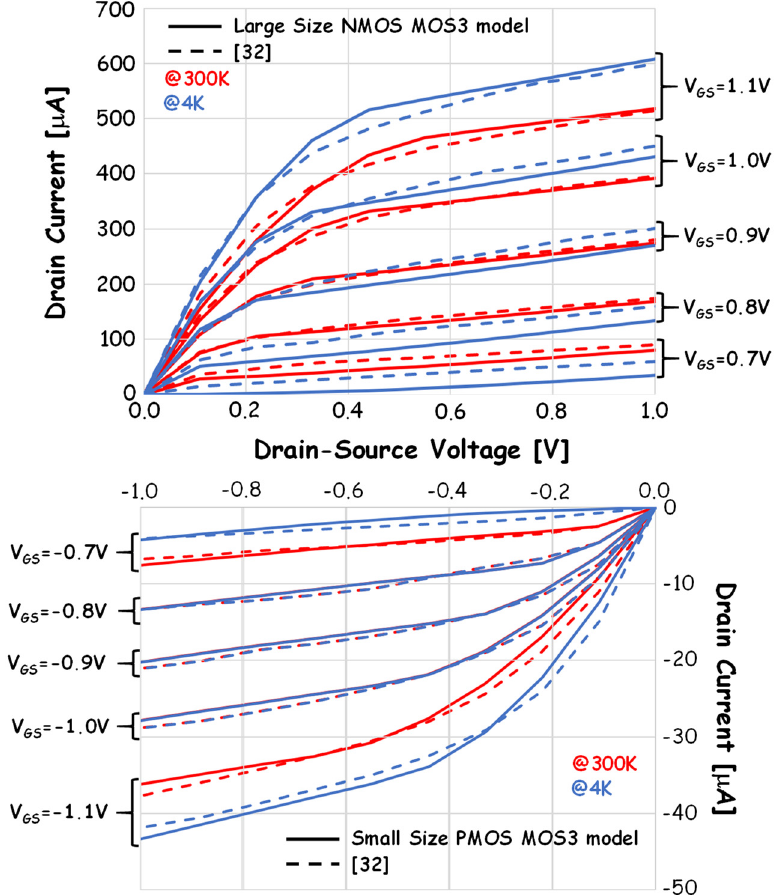
Figure 2. Output characteristics of the large-size NMOS ( upper ) and the small-size PMOS ( lower ) transistors. Dashed lines: from [32], solid lines from MOS3 model. Red curves: 300 K, blue curves: 4 K.